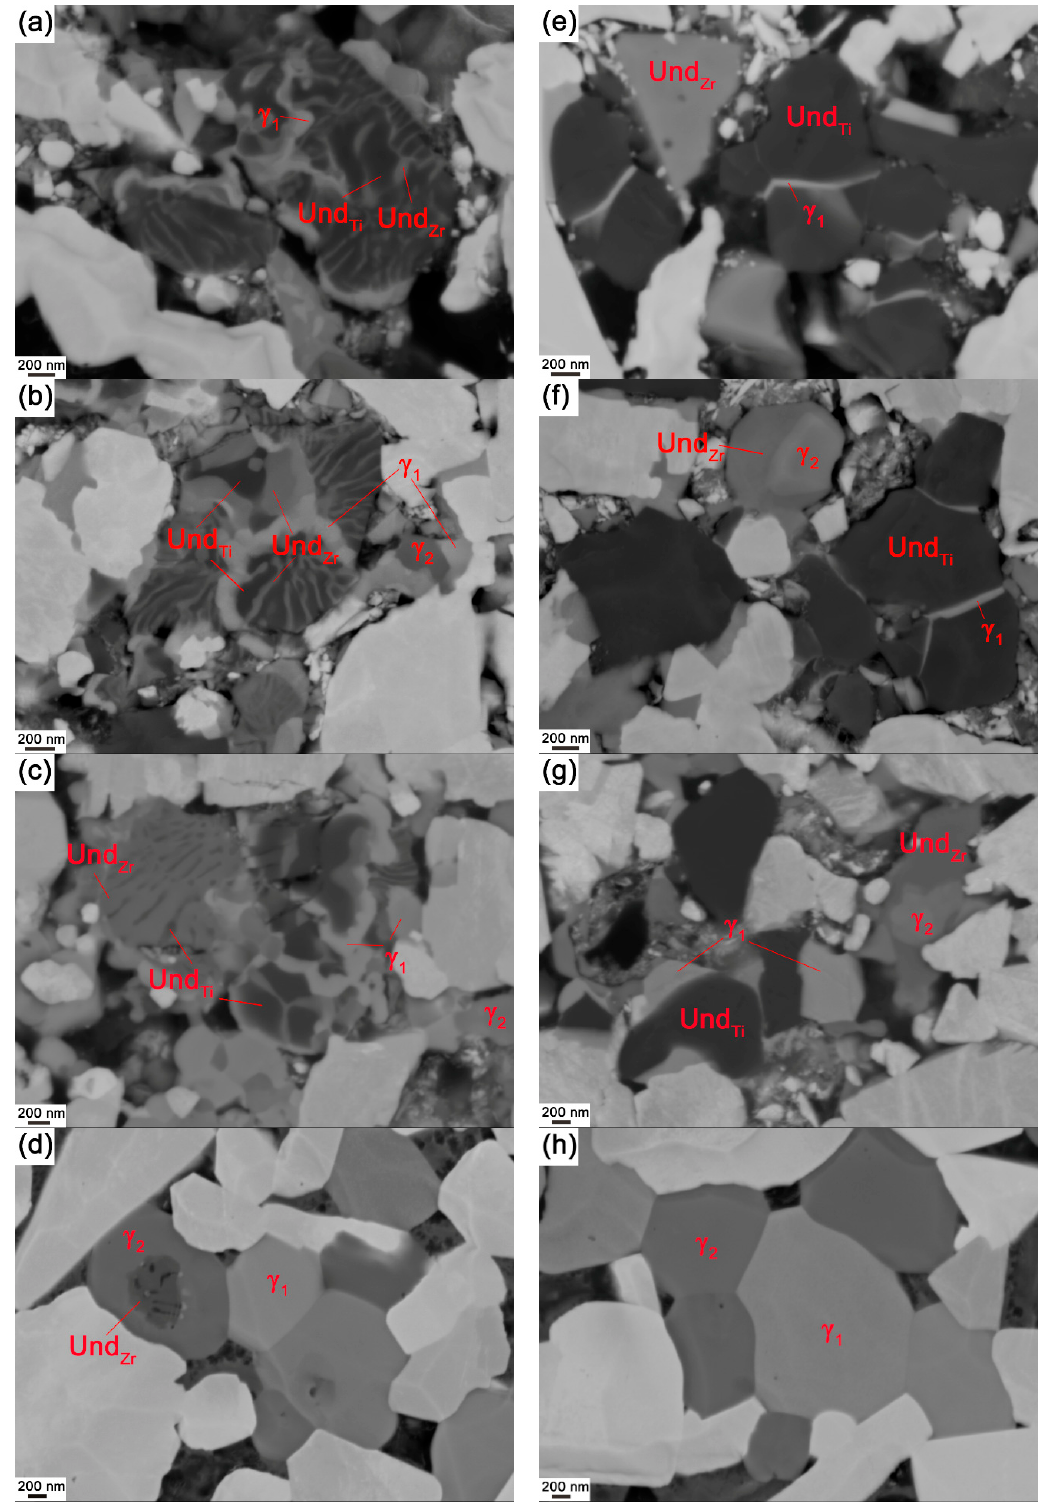
Figure 5. SEM backscattered electron micrographs of cubic carbide phases in composite 1 interruptedly sintered at ( a ) 1310 °C; ( b ) 1325 °C; ( c ) 1345 °C; ( d ) fully sintered; and in composite 2 interruptedly sintered at ( e ) 1310 °C; ( f ) 1325 °C; ( g ) 1345 °C; ( h ) fully sintered. Und Ti and Und Zr represent undissolved Ti-rich and Zr-rich original cubic carbide phases respectively.